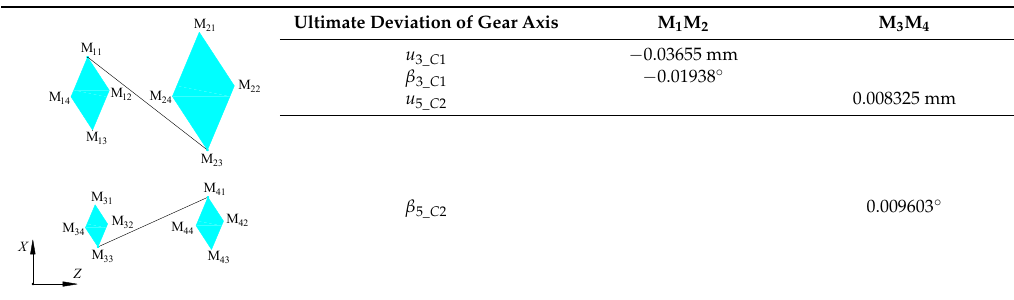
Table 3. Variation ranges of four end points of the gear axis (Unit: mm).